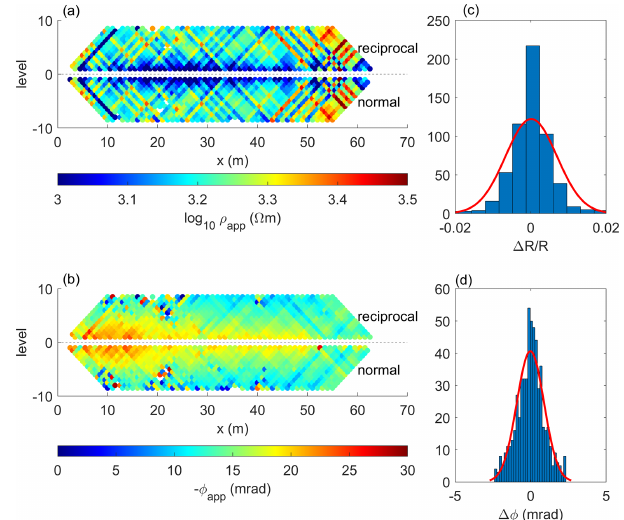
Figure 4. Raw data analysis. Raw-data pseudosections of (a) the ap- parent resistivity and (b) the apparent phase shift for measurements collected along profile By 25. Histograms of the normal–reciprocal misfits of (c) the measured resistance (normalized) and (d) the ap- parent phase shift.